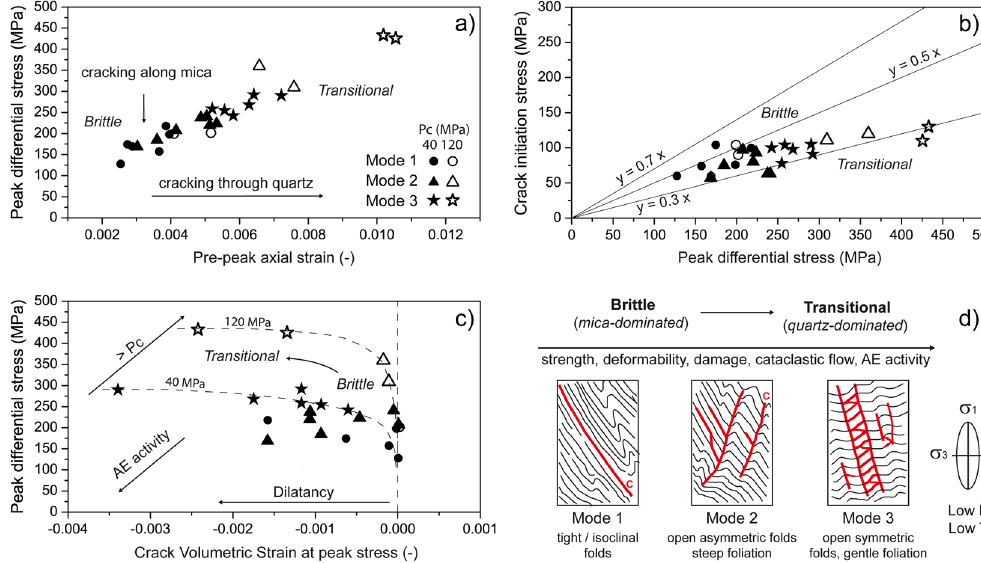
Figure 4. Conceptual model constrained by damage proxies (complete experimental dataset). ( a ) peak differential stress (PDS) vs. pre-peak axial strain shows clear separation among different failure modes (both at 40 and 120 MPa confining pressure); ( b ) crack initiation stress vs. PDS highlights the departure from brittle to a transitional behaviour for rock failed in “quartz-dominated” modes (2 and 3); ( c ) PDS vs. Crack Volumetric Strain shows higher dilatancy and strength associated to transitional behaviour in “quartz-dominated” failure modes, whereas rocks failed in “mica-dominated” mode 1 are weaker and brittle. ( d ) conceptual model of the observed mechanical